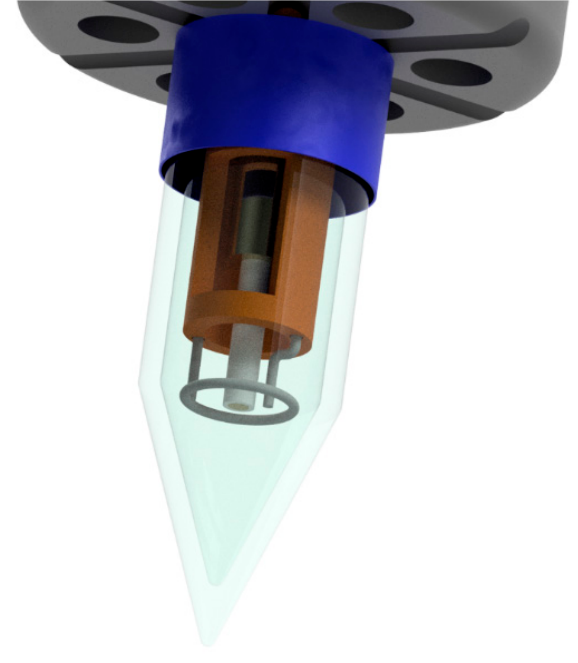
Figure 7. A 3-D illustration of the miniaturized sensor probe containing the three electrodes placed inside a 5 mL sample chamber.